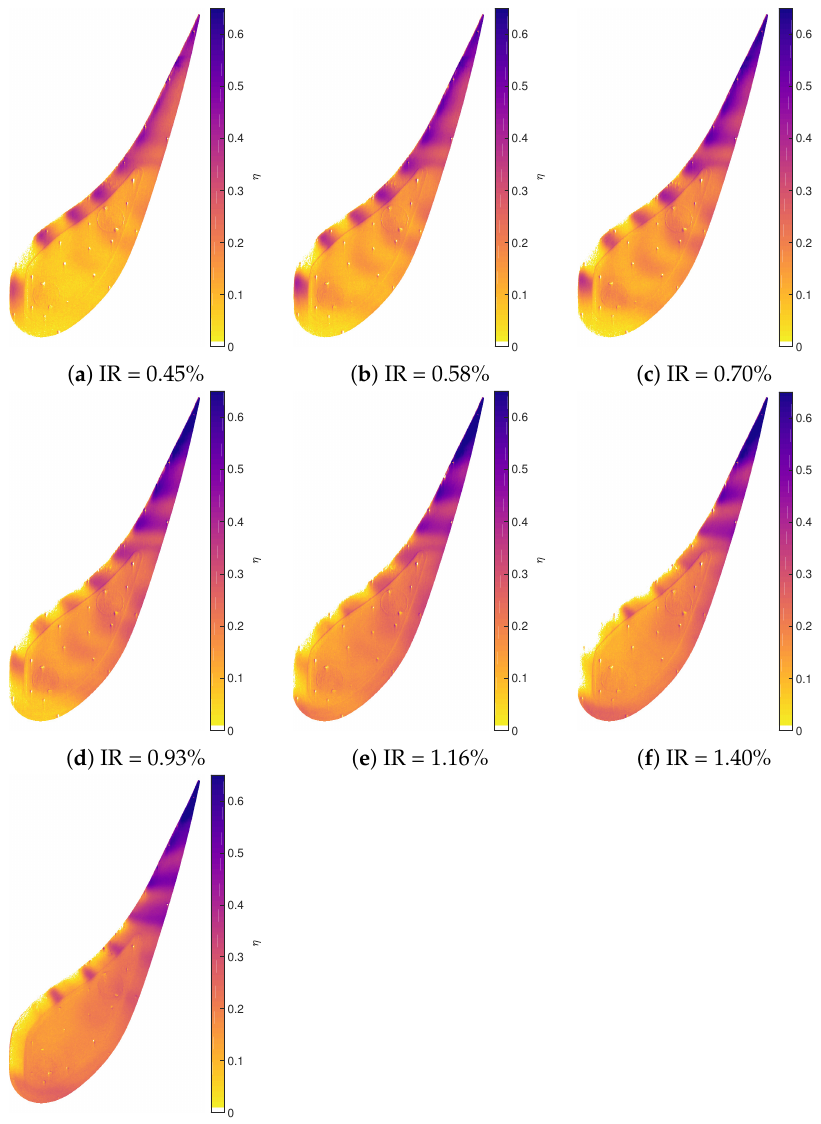
Figure 9. Cooling effectiveness η for axial inflow.